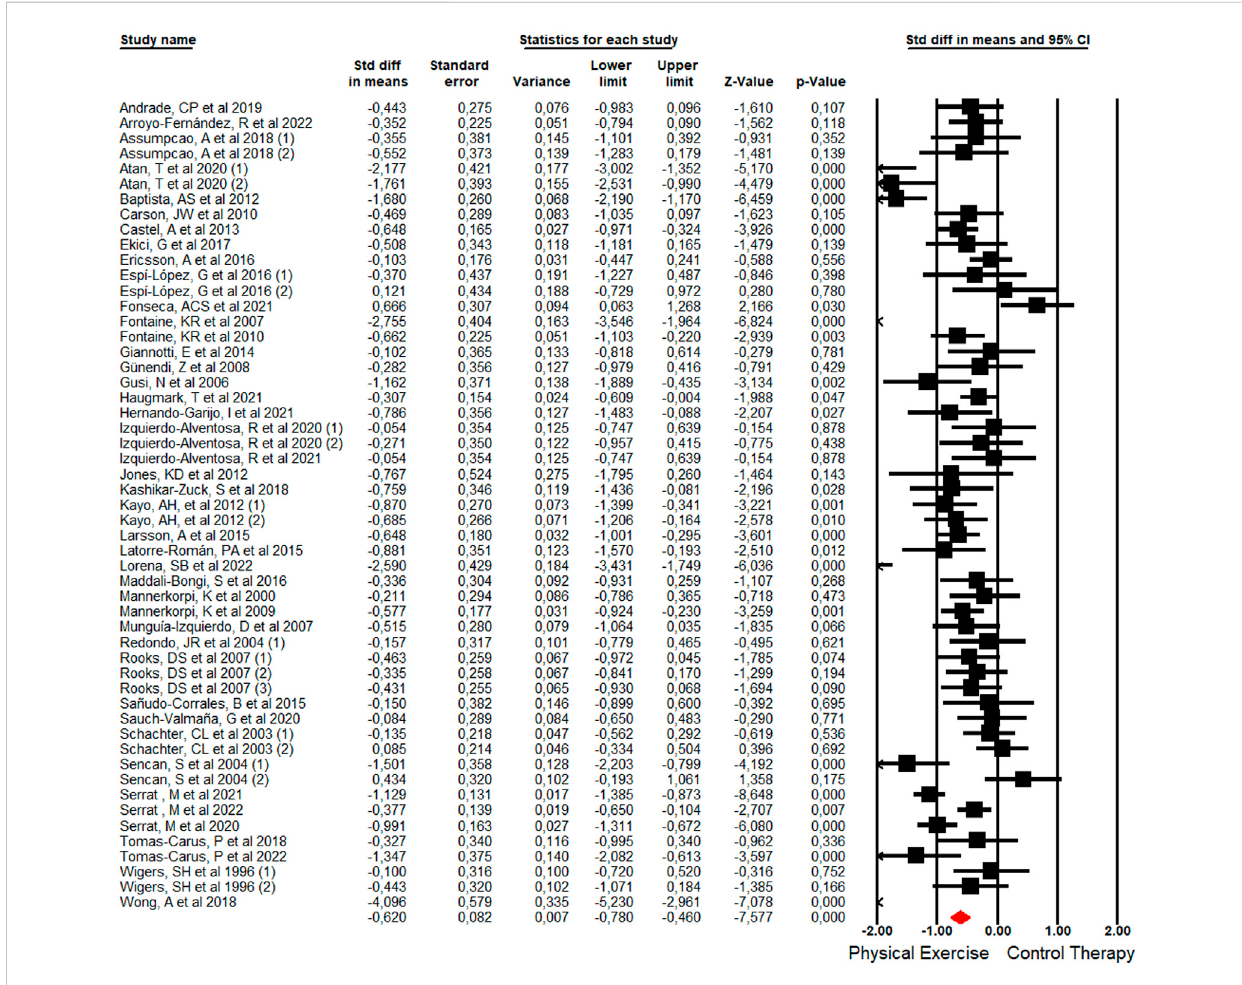
FIGURE 2 Forest Plot of the immediate effect of PEBT on